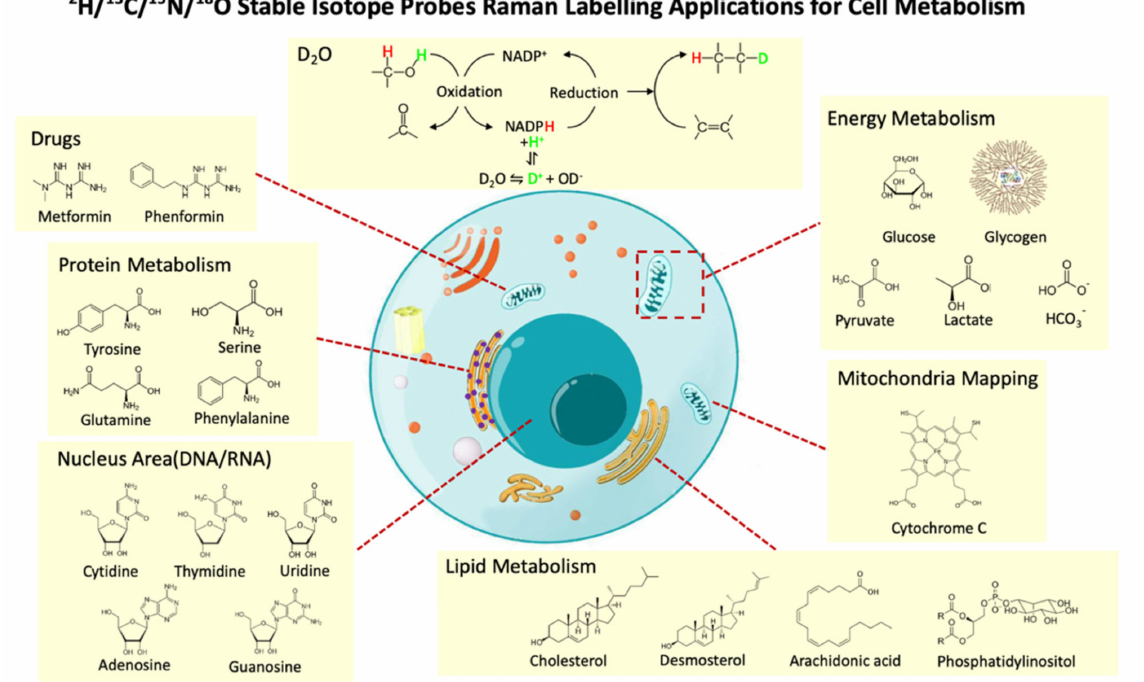
Figure 6. Raman–SIP strategies to study cellular metabolism. Heavy water (D 2 O) is involved in NADPH regeneration, which is able to indicate the general anabolism activity in cells. Stable isotope labeled sugars, amino acids, nucleic acids, lipid precursors, and drugs can be used to probe the dynamics of metabolic flux and interactions of drugs and cancer